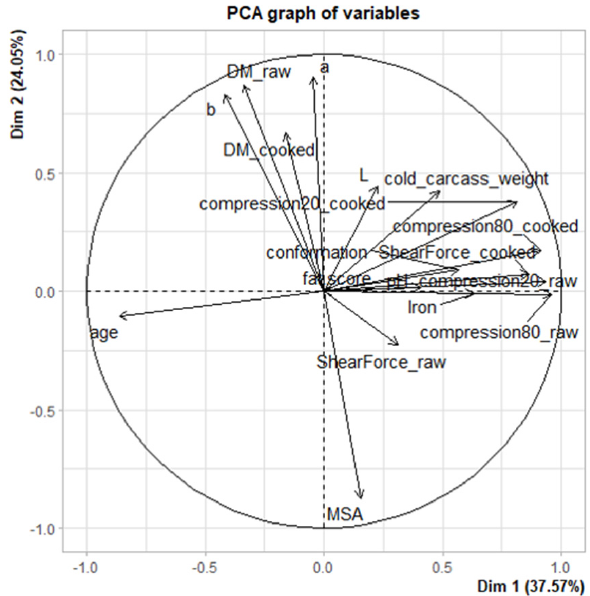
Figure 8. Correlation circle for principal component analysis 2 performed on 8 samples by using the difference between T1 and T4. DM_raw, DM_cooked: Dry Matter on raw or cooked meat;